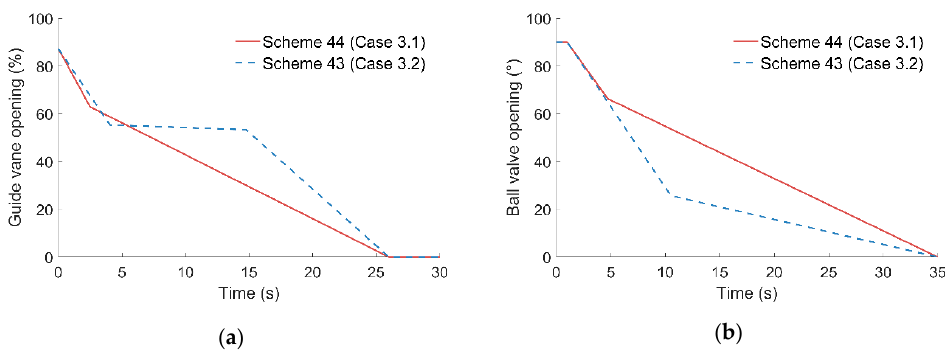
Figure 18. Comparison of optimized closing schemes in Case 3 for (a) guide vanes and ( b ) ball valve. Table 5. Partial Pareto optimal solutions by different closing operations.